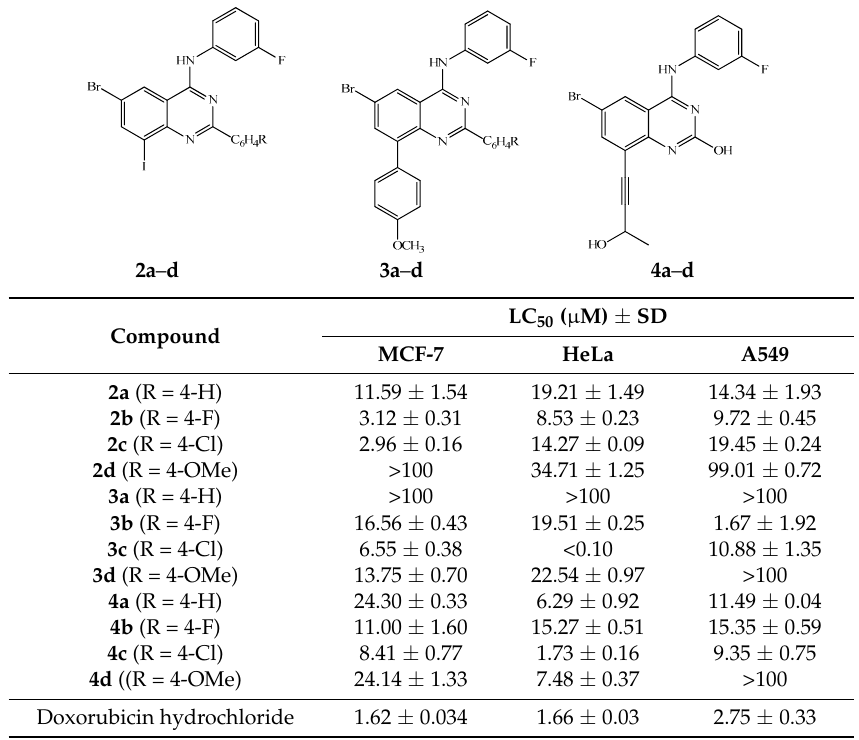
Molecules 2016 , 21 , 1366 Table 7. Cytotoxic effects of 2a – d , 3a – d and 4a – d against MCF-7, HeLa and A549 cell lines.